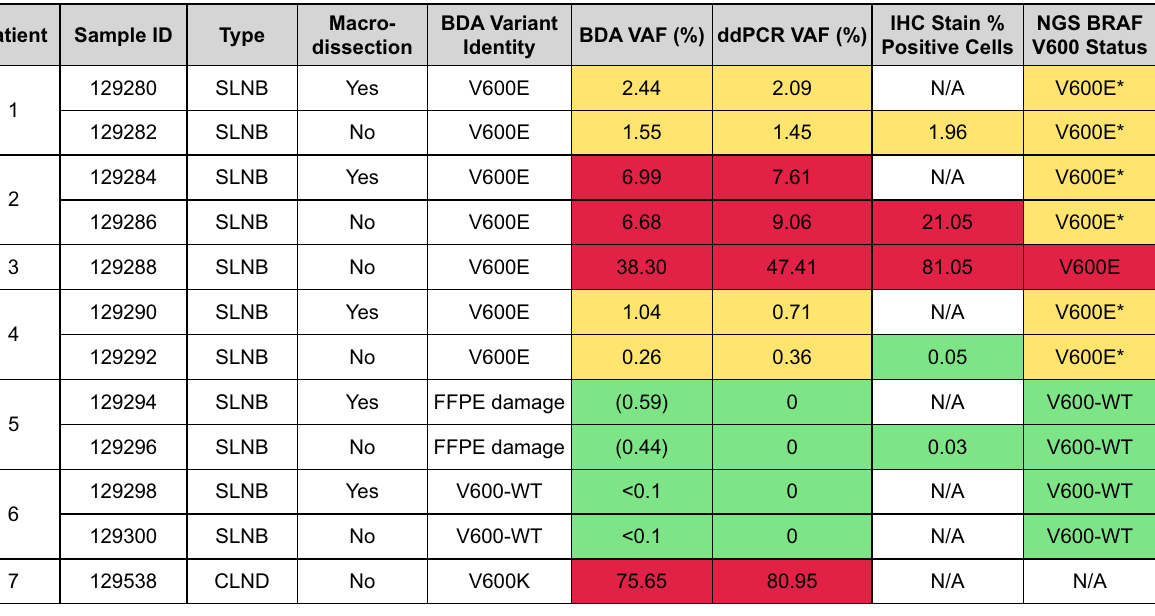
Table 1. Clinical sample summary of comparative analytical results. DNA was extracted from FFPE SLNB or CLND specimens from non-acral cutaneous melanoma patients. Samples were derived from 7 patients. Macrodissection was performed to enrich tumor fraction except for samples 129288 and 129538 that were tumor only. Samples results are shown for BDA Sanger sequencing assay, ddPCR assay, IHC using anti-BRAF V600E antibody staining, and NGS. DNA input for BDA Sanger and ddPCR assays were 40ng each (roughly 1/50th the DNA from 1 FFPE slide); other methods used a full slide. Red cells code for VAF 5%, yellow cells code ≥ for 0.1% ≤ VAF < 5%, green cells code for wild type. BDA Sanger identified and quantitated FFPE damage at 0.59% VAF and 0.44% VAF for the 129294 and 129296 samples, but reported 0% VAF for BRAF actionable mutations. “*” indicated that the NGS status was confirmed with orthogonal NGS